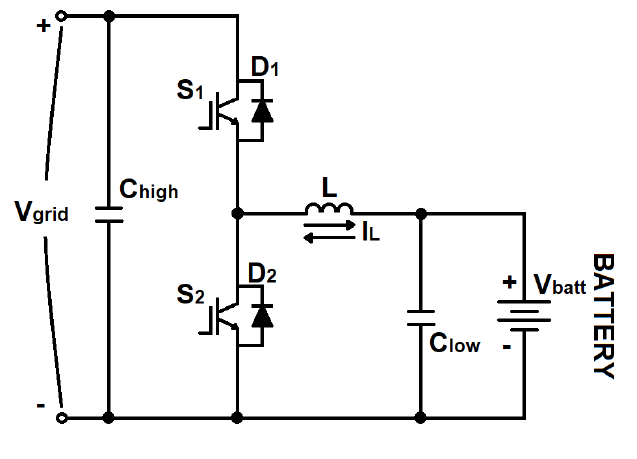
Figure 5. Topology of single-phase bidirectional buck–boost converter.